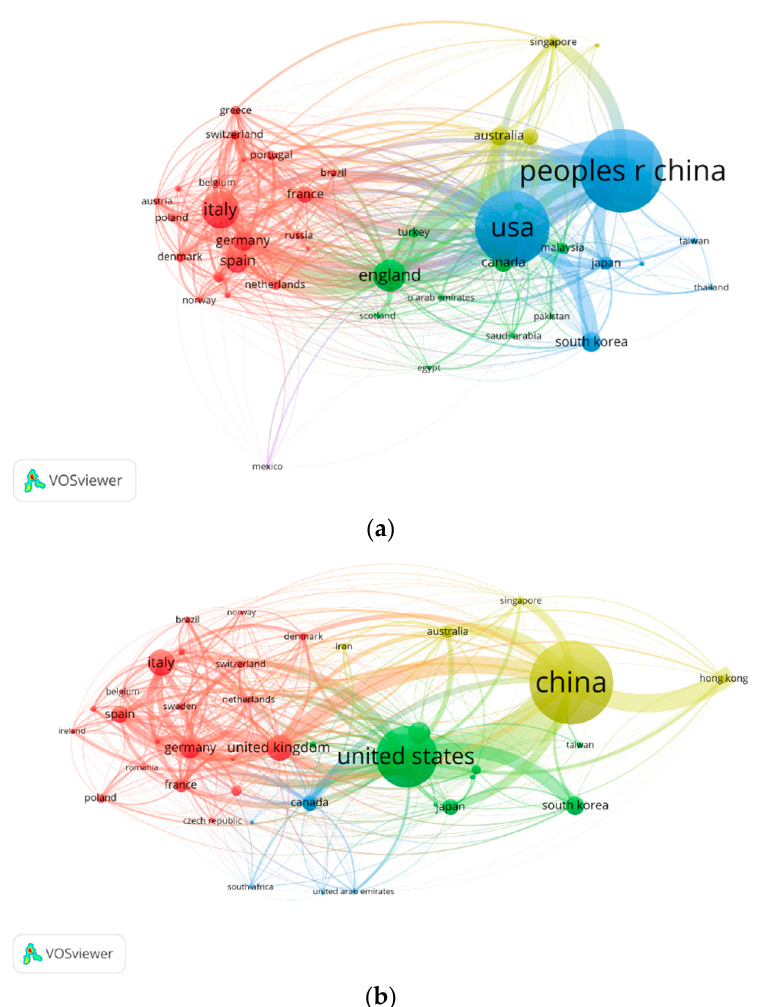
Figure 5. Network of countries with the highest number of documents in the topic of study during the period January 2013–September 2019: ( a ) Web of Science; ( b ) Scopus.